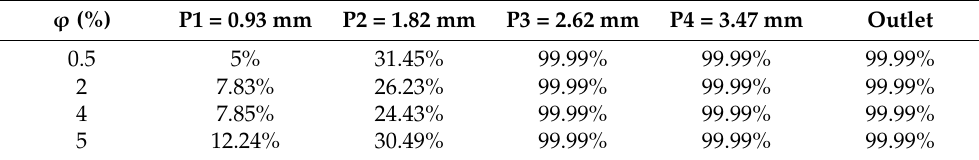
Table 4. Local Temperature PDF ranging from 314 K to 316 K for different